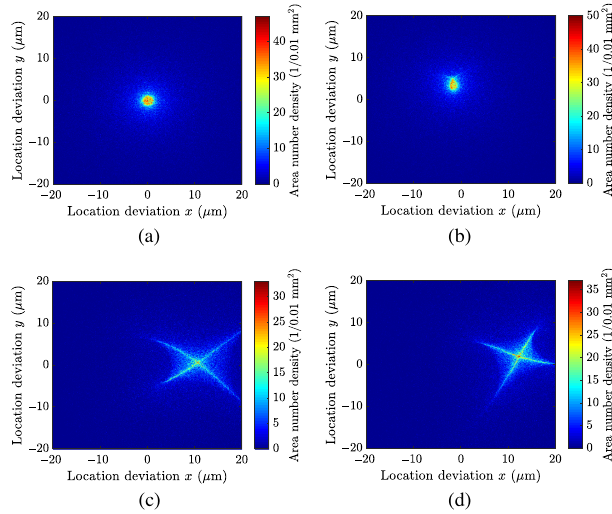
FIG. 4. Beam profiles of transported protons at the center of the LIGHT beamline (2.5 m from its origin). The deviations of these beam profiles are due to the different magnetic field distributions used in the simulations. (a) Corresponding beam profileto the symmetric ring wires, (b)corresponding beam profile to the connected helix wires, (c) corresponding beam profile to the symmetric ring wires with connection cables ( α ¼ 60 °) and (d) corresponding beam profile to the realistic wire geometry.